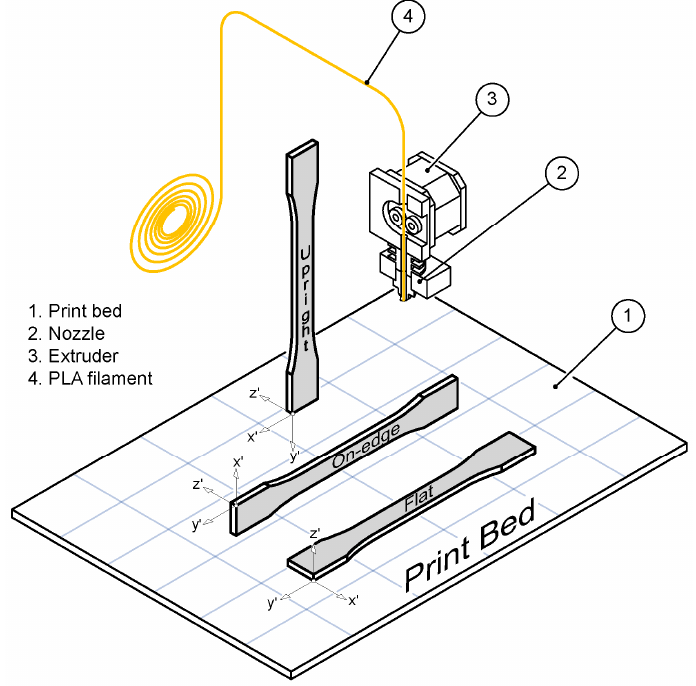
Figure 2. Witbox desktop 3D printer system. Details of the printing process and build orientation.